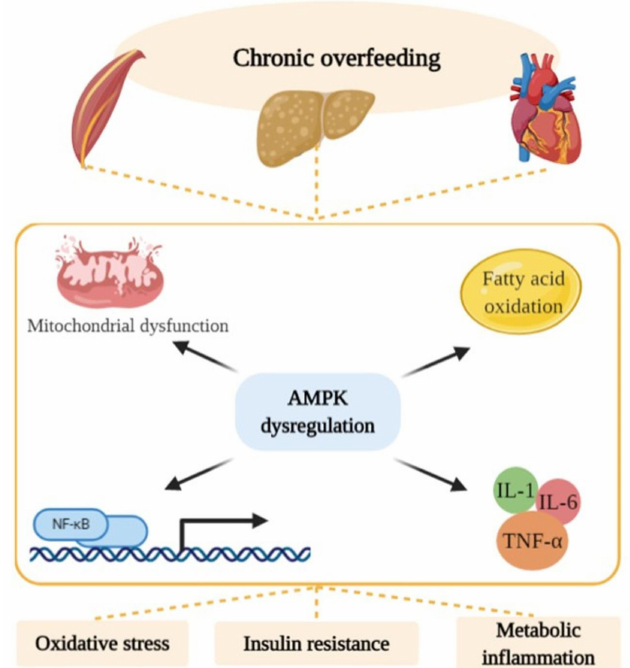
Figure 2. Chronic overnutrition and ectopic lipid accumulation reduces AMP-activated protein kinase (AMPK) activity in multiple non-adipose tissues. The prolonged inactivation of AMPK may be responsible, at least in part, for alterations in mitochondrial function, fatty acid (FA) oxidation, activation of nuclear factor kappa-light-chain-enhancer of activated B cells (NF- κ B) signalling and the consequent appearance of a low-grade metabolic inflammation, oxidative stress and insulin